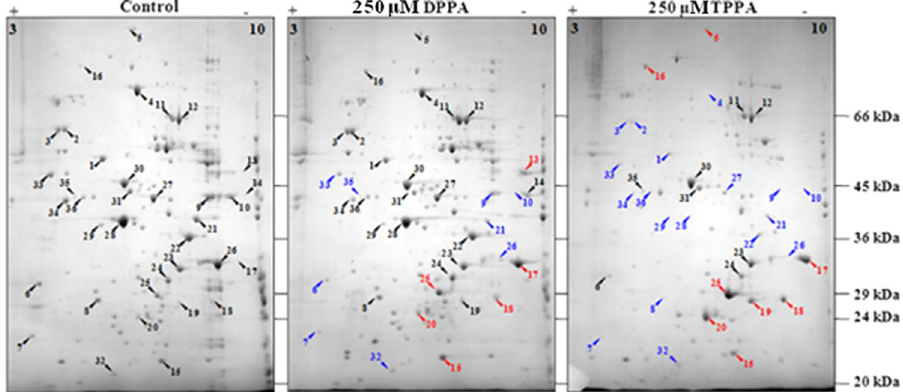
Figure 5. 2D gel images indicating whole cell protein profile of the control or drug treated silk glands. Constitutively expressed, or induced, or repressed proteins are indicated by black, red, or blue arrow heads, respectively, and by numbers as given in the Supplementary Table 4. Molecular mass (kDa) and pI are shown on right-hand side and on top,